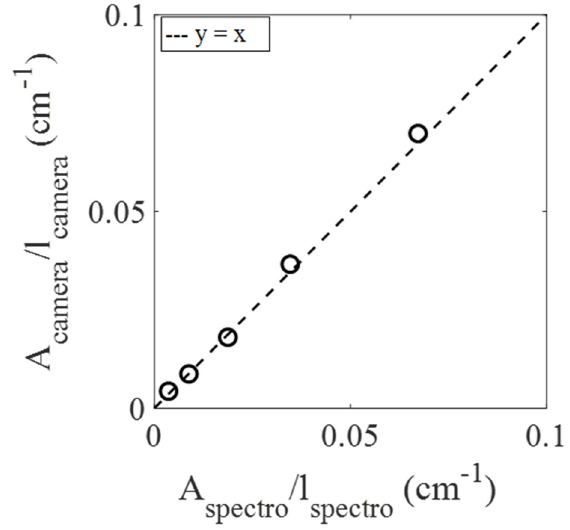
Figure 3. Comparison of the ratios of the absorbance to the optical path length obtained by the spectrophotometer and the camera technique.